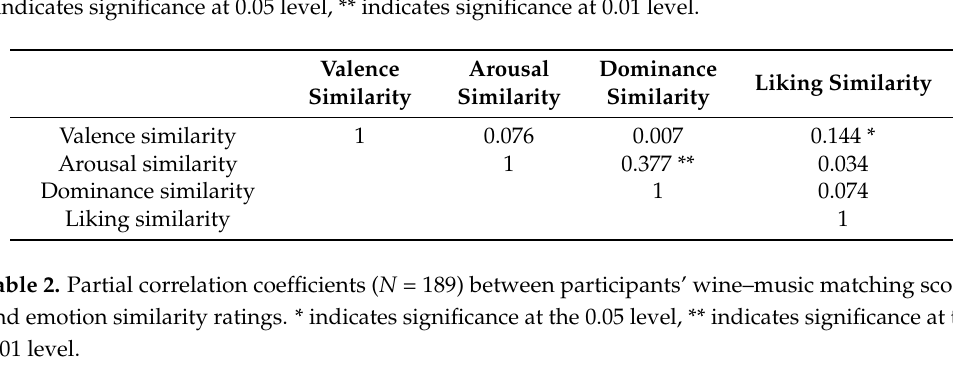
Table 1. Pearson correlation coefficients ( N = 189) amongst participants’ emotion similarity ratings. * indicates significance at 0.05 level, ** indicates significance at 0.01 level.